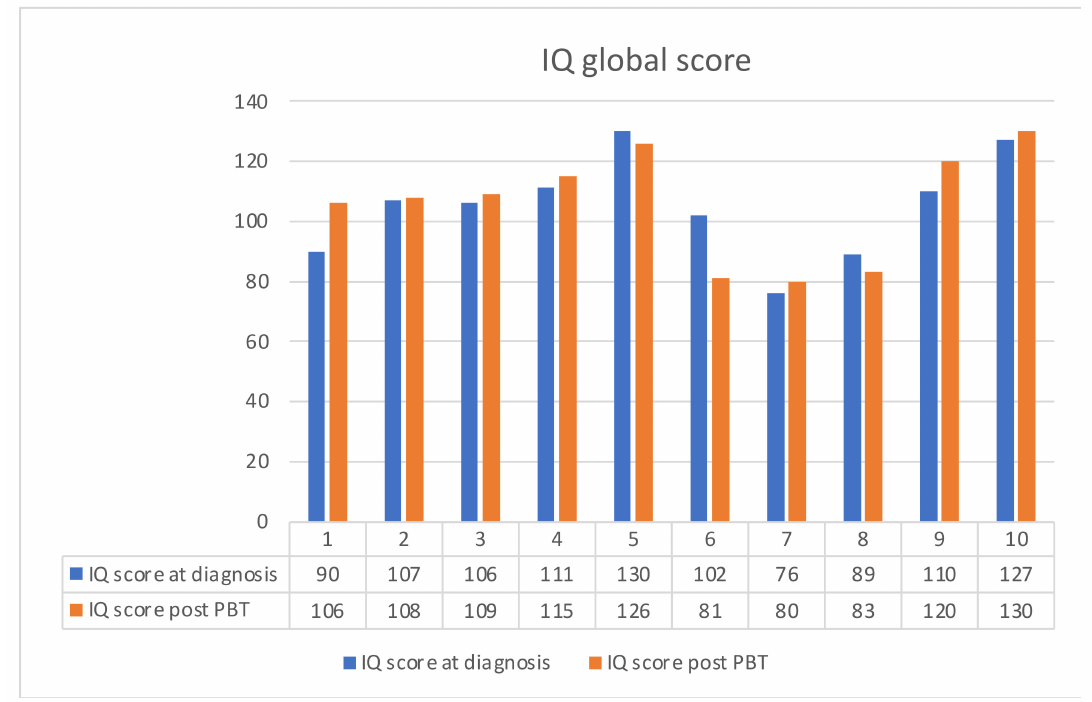
Figure 2. Neurocognitive performance score at diagnosis and after PBT. Detailed single-patient characteristics are described in Table